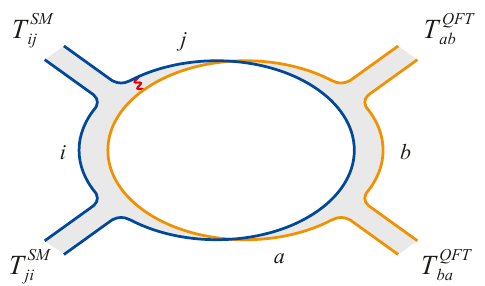
Figure 2 . The 1-loop diagram with two gauge (cid:12)elds from QFT N and two from the SM, in a \double line" notation. The a; b and i; j indexes denote the colours of the QFT N and the SM respectively. The lines denote the index contractions of the hidden theory and the SM.